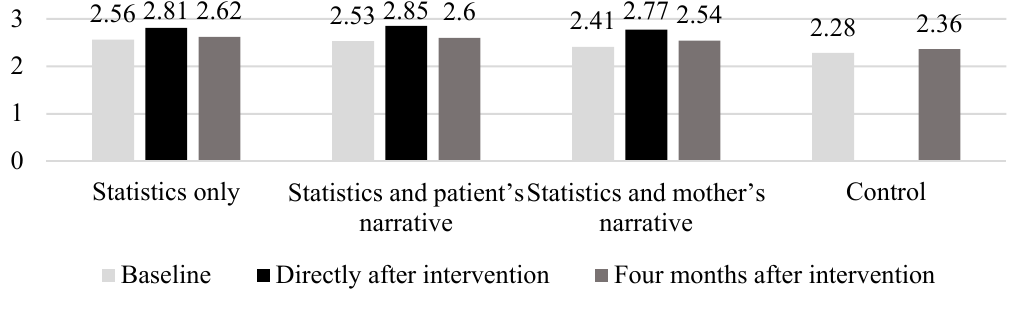
Figure 1. Mean of vaccination intention at baseline, directly after, and four months after intervention across groups.